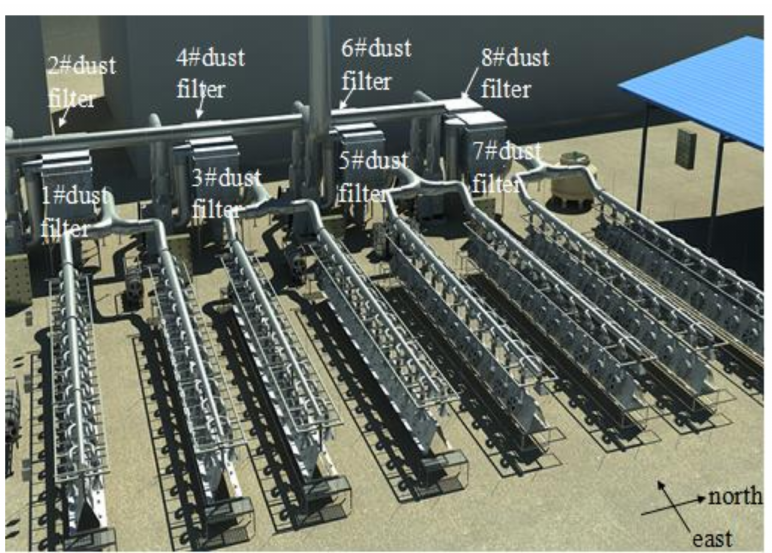
Figure 4. Production lines with workstations. From Li et al. (2016). Copyright (2016), with permission from